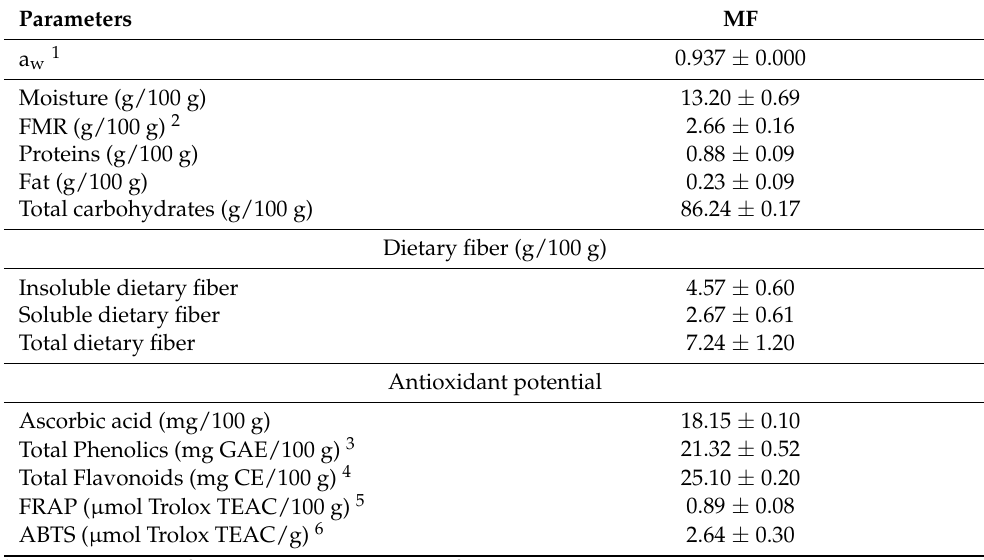
Table 1. Physicochemical characteristics (media ± standard deviation) of the in natura mandacaru cladode ( Cereus jamacaru DC.) used in the preparation of